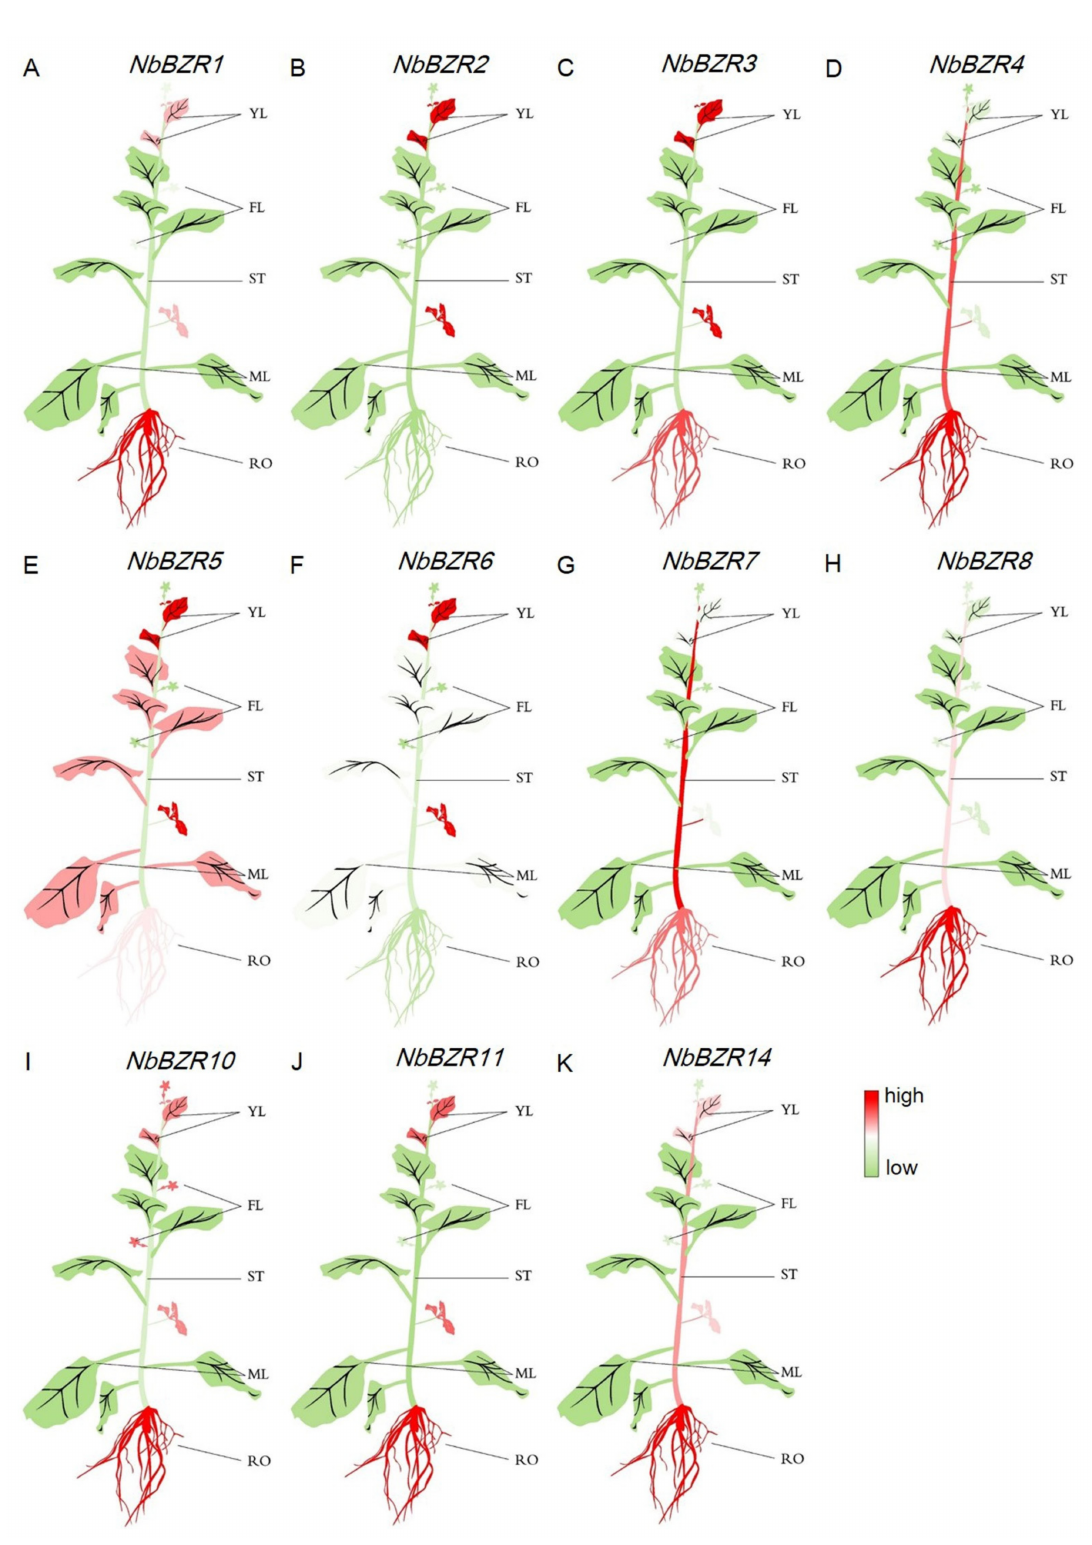
Figure 4. Expression levels of NbBZRs in different tissues ( A – K ). The mean expression values were calculated from three independent biological replicates relative to that in young leaves. YL: young leaf; MF: mature leaf; ST: stem; RO: root; FL: flower. Red represents a high expression level and green represents a low expression level. The raw data of relative expression values and standard errors are provided in Supplementary Figure